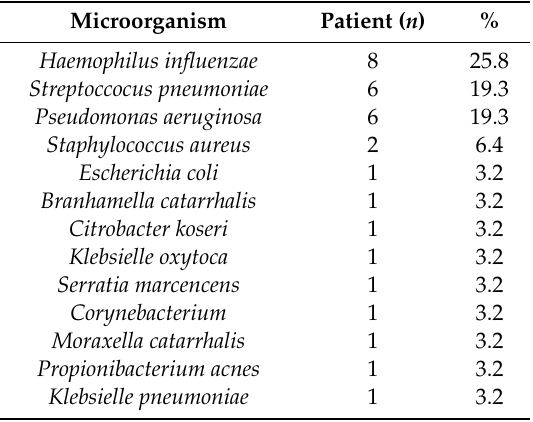
Table 3. Middle meatus bacteriological analysis ( n =